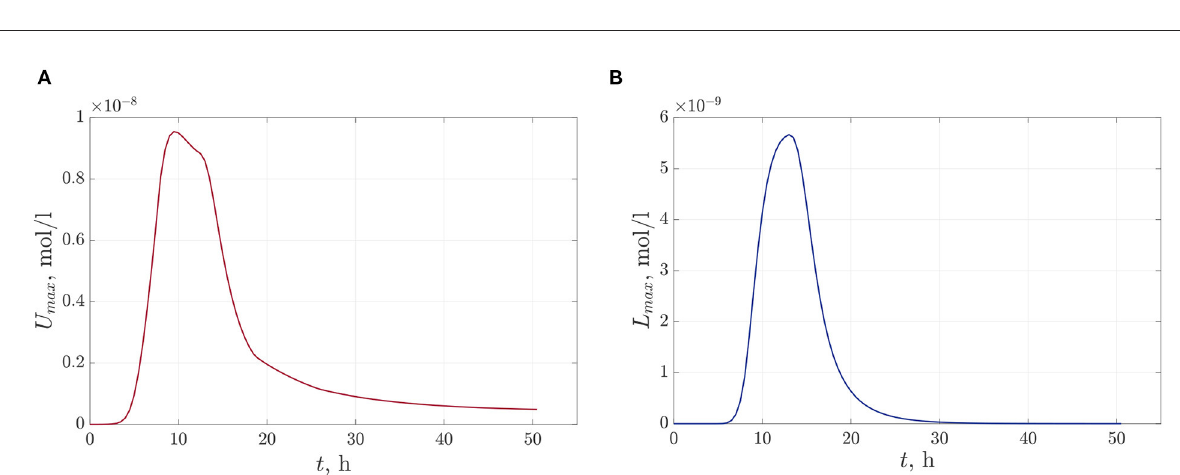
AHL concentration equals 1.36 · 10 − 10 mol/l at the final time